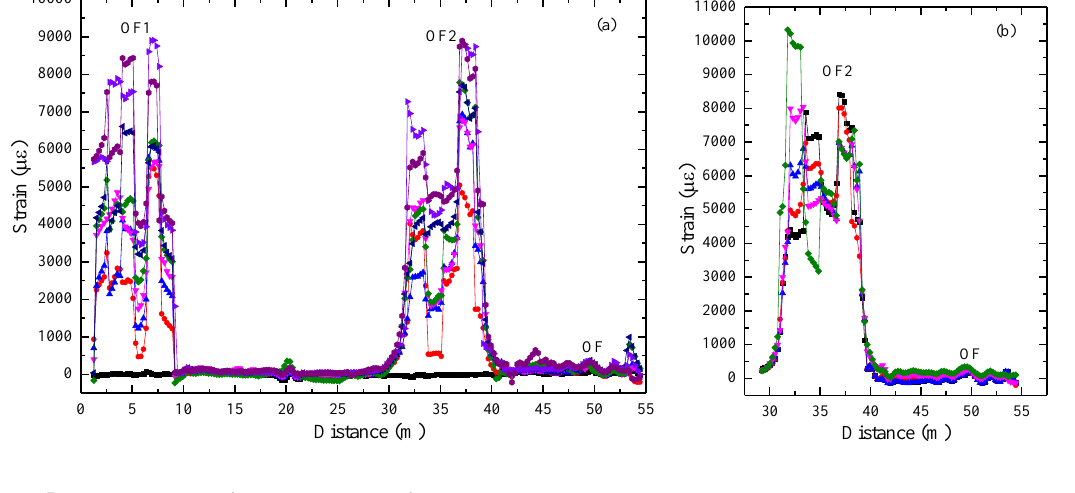
Figure 21. Experimental data: ( a ) Strain measurement of N1; ( b ) Strain measurement of N2.